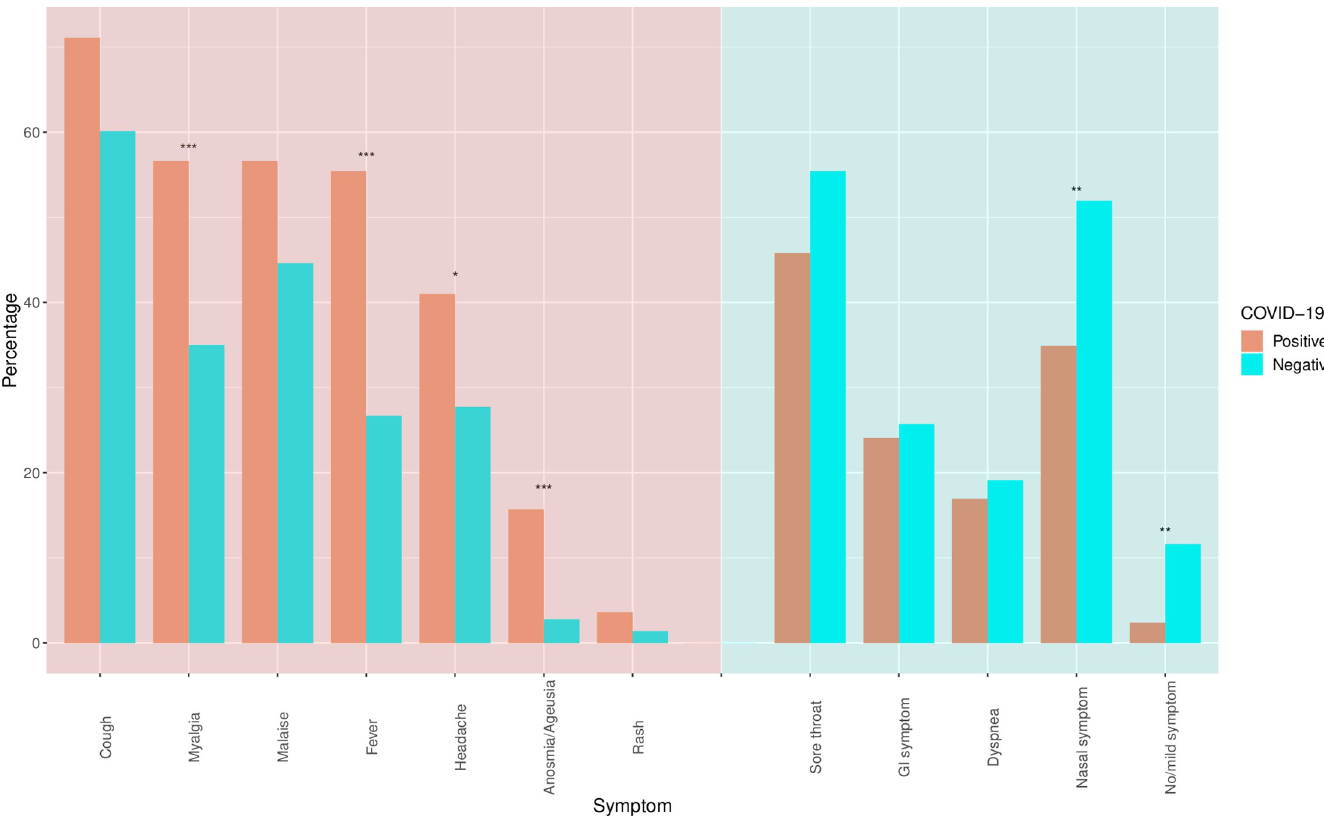
Fig 1. Symptom distributions among HCWs with initial SARS-CoV-2 (the virus causing COVID-19) testing results. The symptoms shaded in salmon-red are the symptoms more frequently seen with positive tests, and the symptoms shaded in blue-green are more frequently seen with negative tests. GI symptom denotes a gastrointestinal symptom (nausea/ vomiting/ diarrhea). Nasal symptom includes runny nose, sneezing, congestion, and sinus symptoms. No/mild symptom denotes no symptom or only sore throat and/or nasal symptoms. The asterisks above the bars denote different statistically significance levels when comparing HCWs with positive assays and HCWs with negative assays ( � : P < 0.05, �� : P < 0.01, ��� : P < 0.001). https://doi.org/10.1371/journal.pone.0235460.g001 positive SARS-CoV-2 assay in both models: OR = 2.41 (95% CI: 1.50–3.89) and OR = 1.83 (95% CI: 1.04–3.23), respectively. Headache was a significant predictor in the age- and sex- adjusted model: OR = 1.84 (95% CI: 1.13–2.96), but not in the all-symptom-adjusted model. Nasal congestive symptoms were a significant negative predictor in both multivariate mod- els: OR = 0.51 (95% CI: 0.31–0.82) and OR = 0.40 (95% CI: 0.23–0.68), respectively.